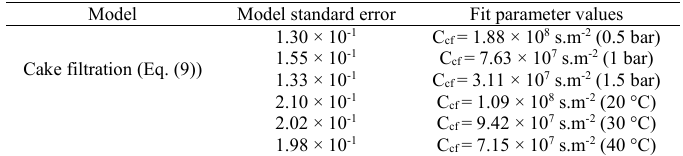
Model Model standard